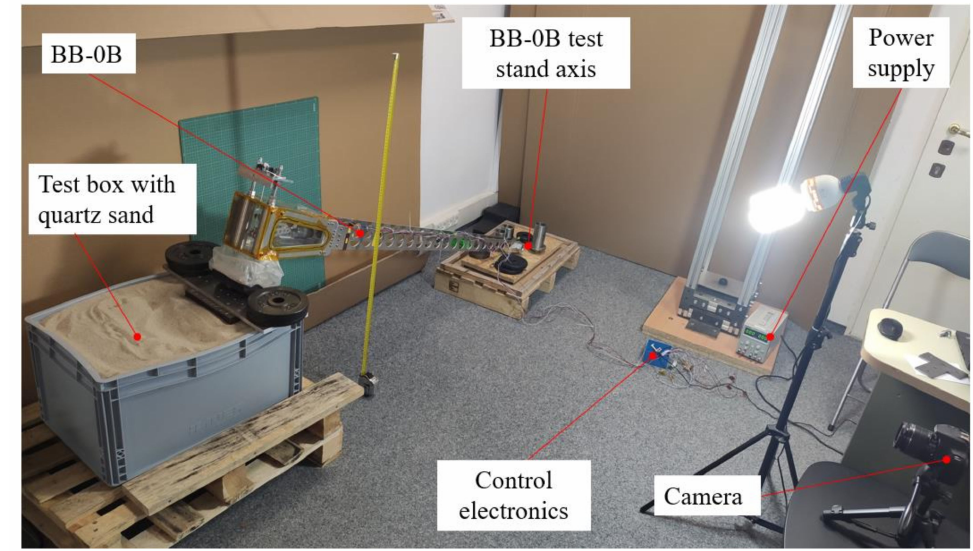
Figure 10. View over typical test scene of the BB-0B.